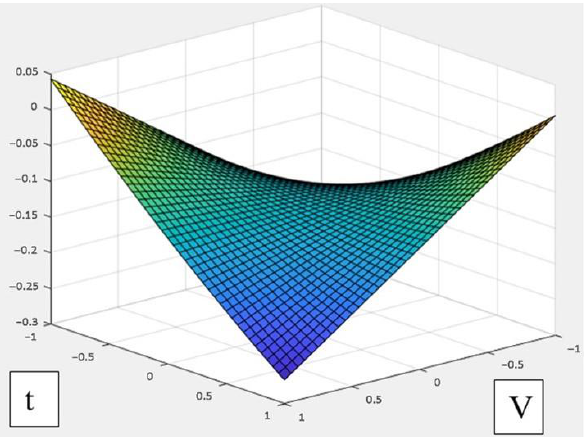
Figure 15. The surface of the change in the criterion logarithm value from the cutting depth and cutting speed encoded values at S = 0.15 mm/rev.